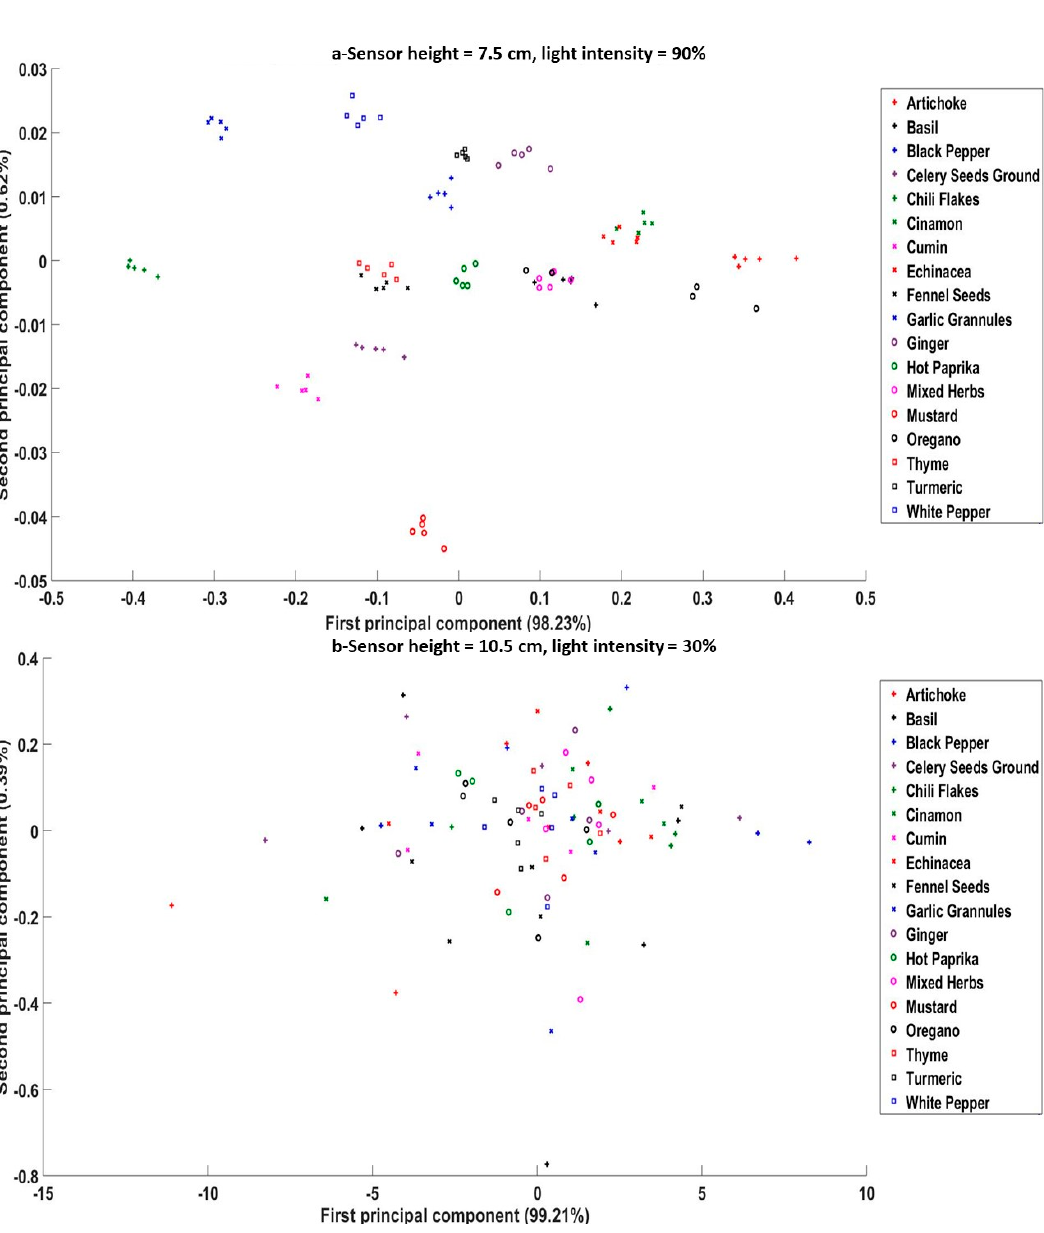
Figure 7. PCA Scatter plots for different spice samples scanned by an NIR sensor at ( a ) sensor height level = 7.5 cm and light intensity = 90%, and ( b ) sensor height level = 10.5 cm and light intensity =